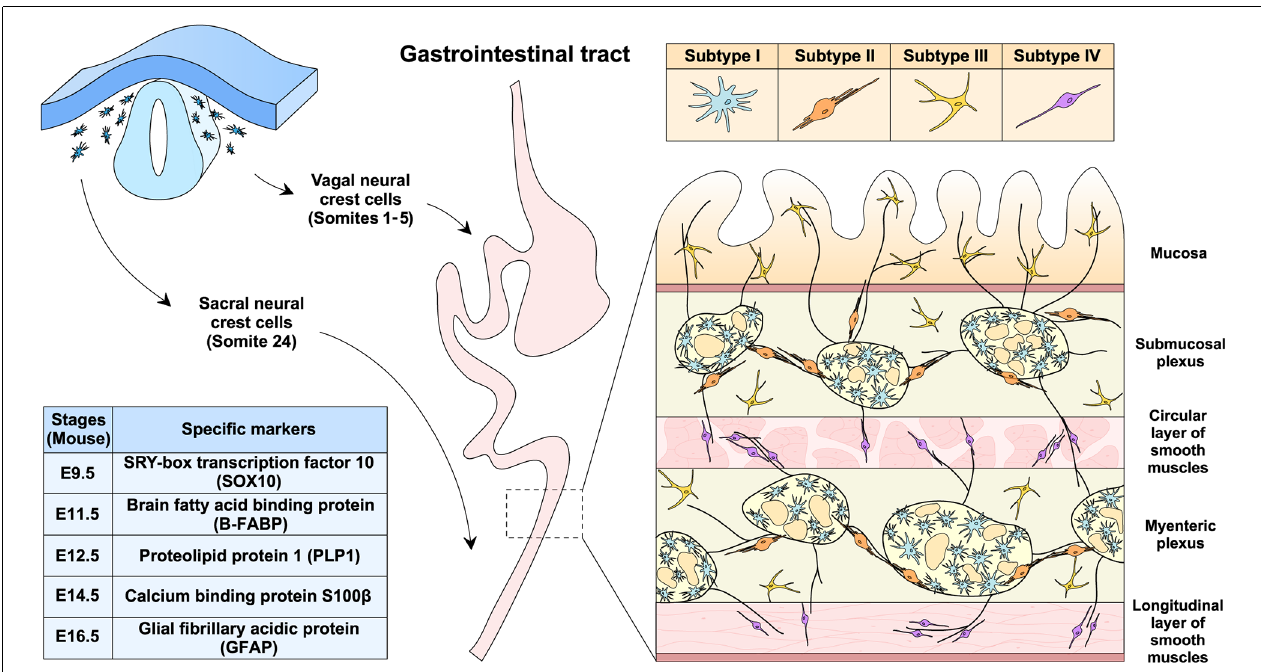
FIGURE 1 | EGCs development, distribution, and classification. EGCs originate from the vagal (somites 1–5) and sacral (somite 24) neural crest cells during embryonic development in the mouse. Progenitor cells of EGCs sequentially express the specific markers, including SOX10 at E9.5, B-FABP at E11.5, PLP-1 at E12.5, S100 β at E14.5, and GFAP at E16.5. In the gastrointestinal tract of adult mice, EGCs could be classified into subtypes I to IV based on cellular morphology and distribution within different anatomical layers. As an integral part of the enteric nervous system, EGCs are present both inside and outside the submucosal and myenteric